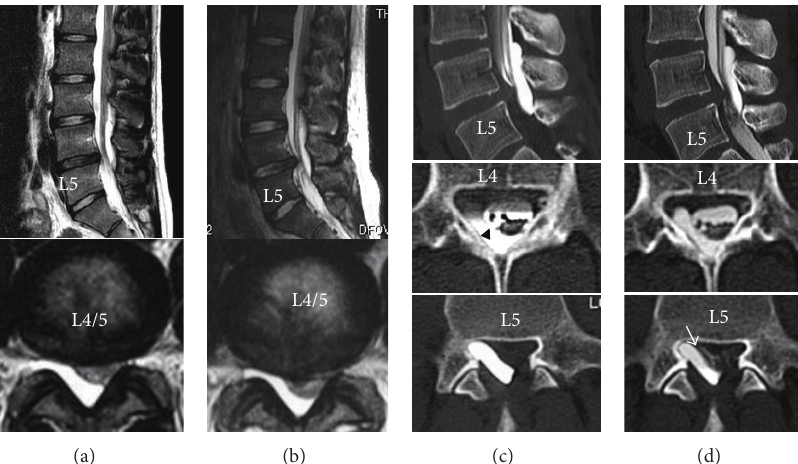
Figure 1: Magnetic resonance (MR) images immediately after injury show a dorsally located cystic lesion extending from L3 to L5 and disc herniation at the L4-L5 level (a). Preoperative magnetic resonance images show progression of herniation and compression of the dural sac (b). Computerized tomography (CT) myelogram shows the communication site at the L4 level ((c), arrowhead). Compression of the cauda equina and blockage of CSF at the L4-L5 level are also shown. CT myelogram obtained 2 h later demonstrates the L5 root sandwiched between the cyst and herniation ((d),